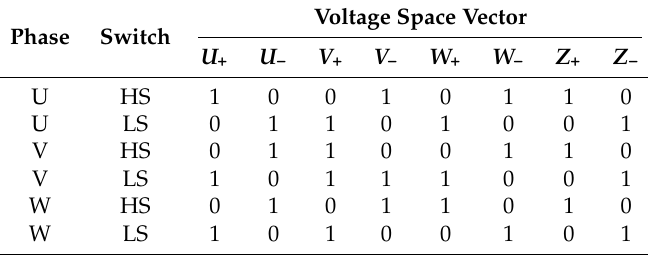
Table 1. Voltage space vector definition of a three-phase inverter.